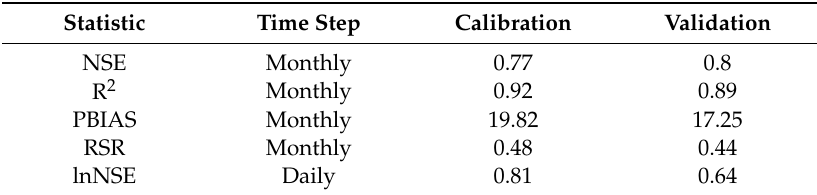
Table 6. SWAT model performance statistics for corrected simulated monthly and daily streamflow during calibration and validation